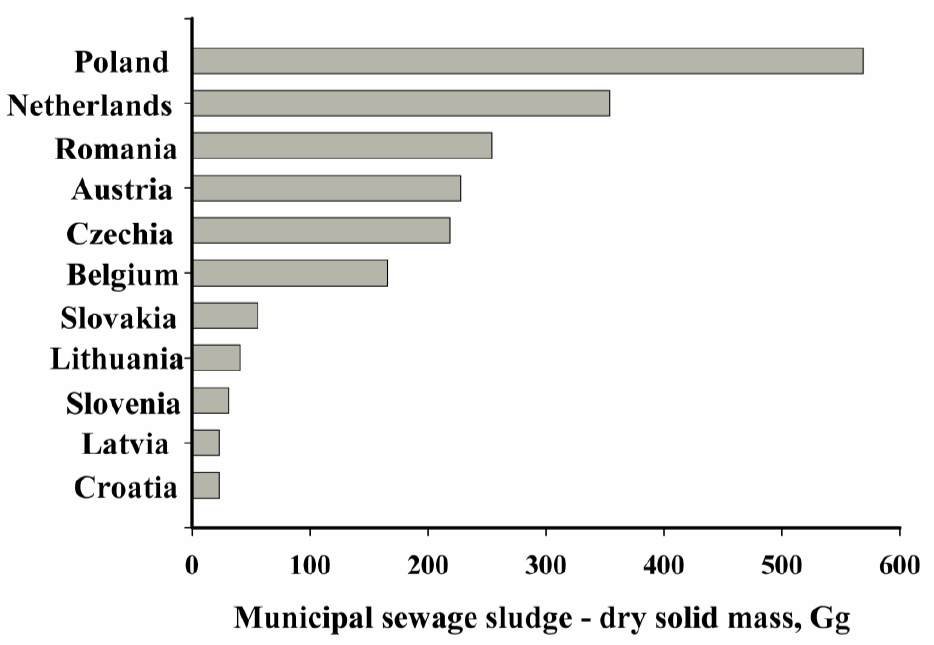
Figure 1. Sewage sludge production volume from municipal wastewater in dry substances in selected EU countries in 2020 [12].